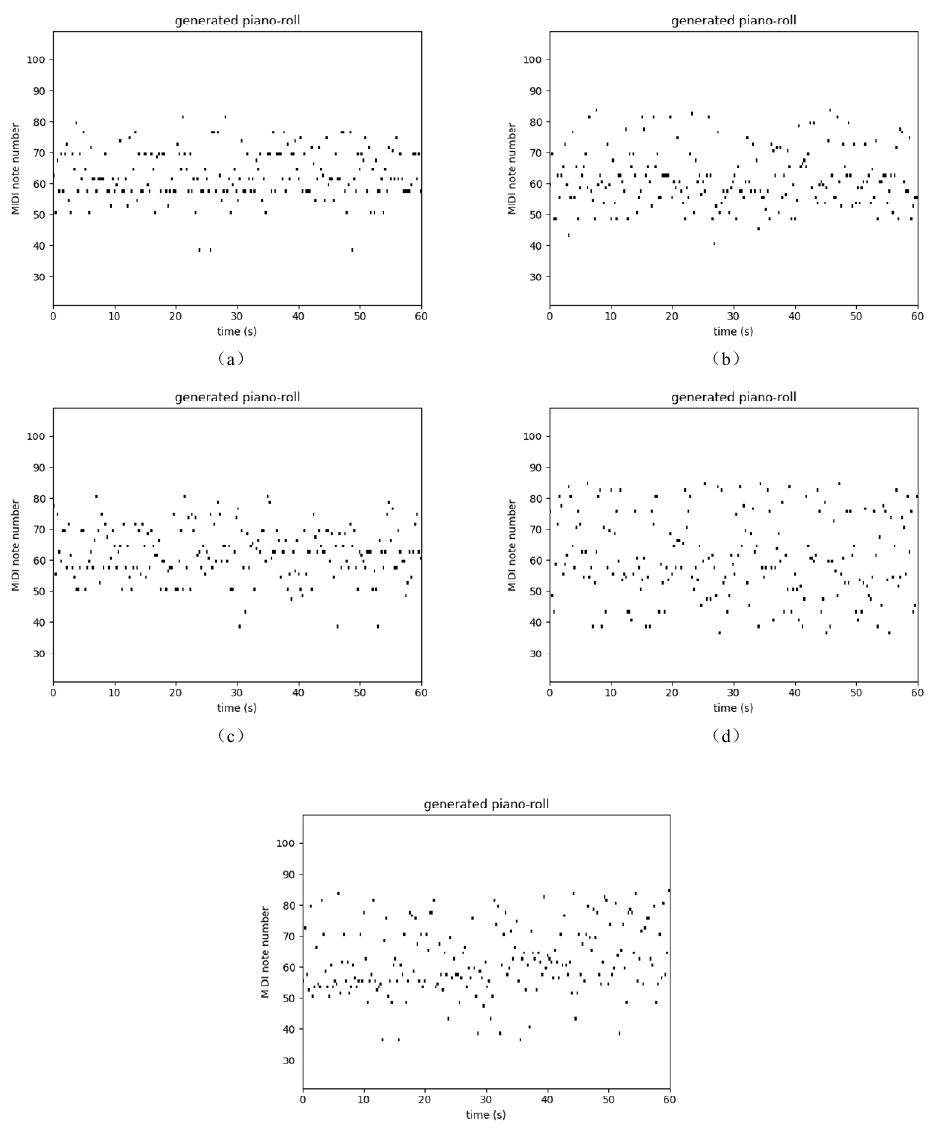
Figure 6. Sample of polyphonic music generation by the ( a ) RNN [9], ( b ) LSTM [16] and ( c ) GRU [17], ( d ) Res-RNN and ( e ) Res-RNN with gates trained with the databases of Nottingham. Table 3. Average performance of the RNN [9], LSTM [16] and GRU [17] and Res-RNN and Res-RNN with gates on different polyphonic databases in 10,000 epochs.